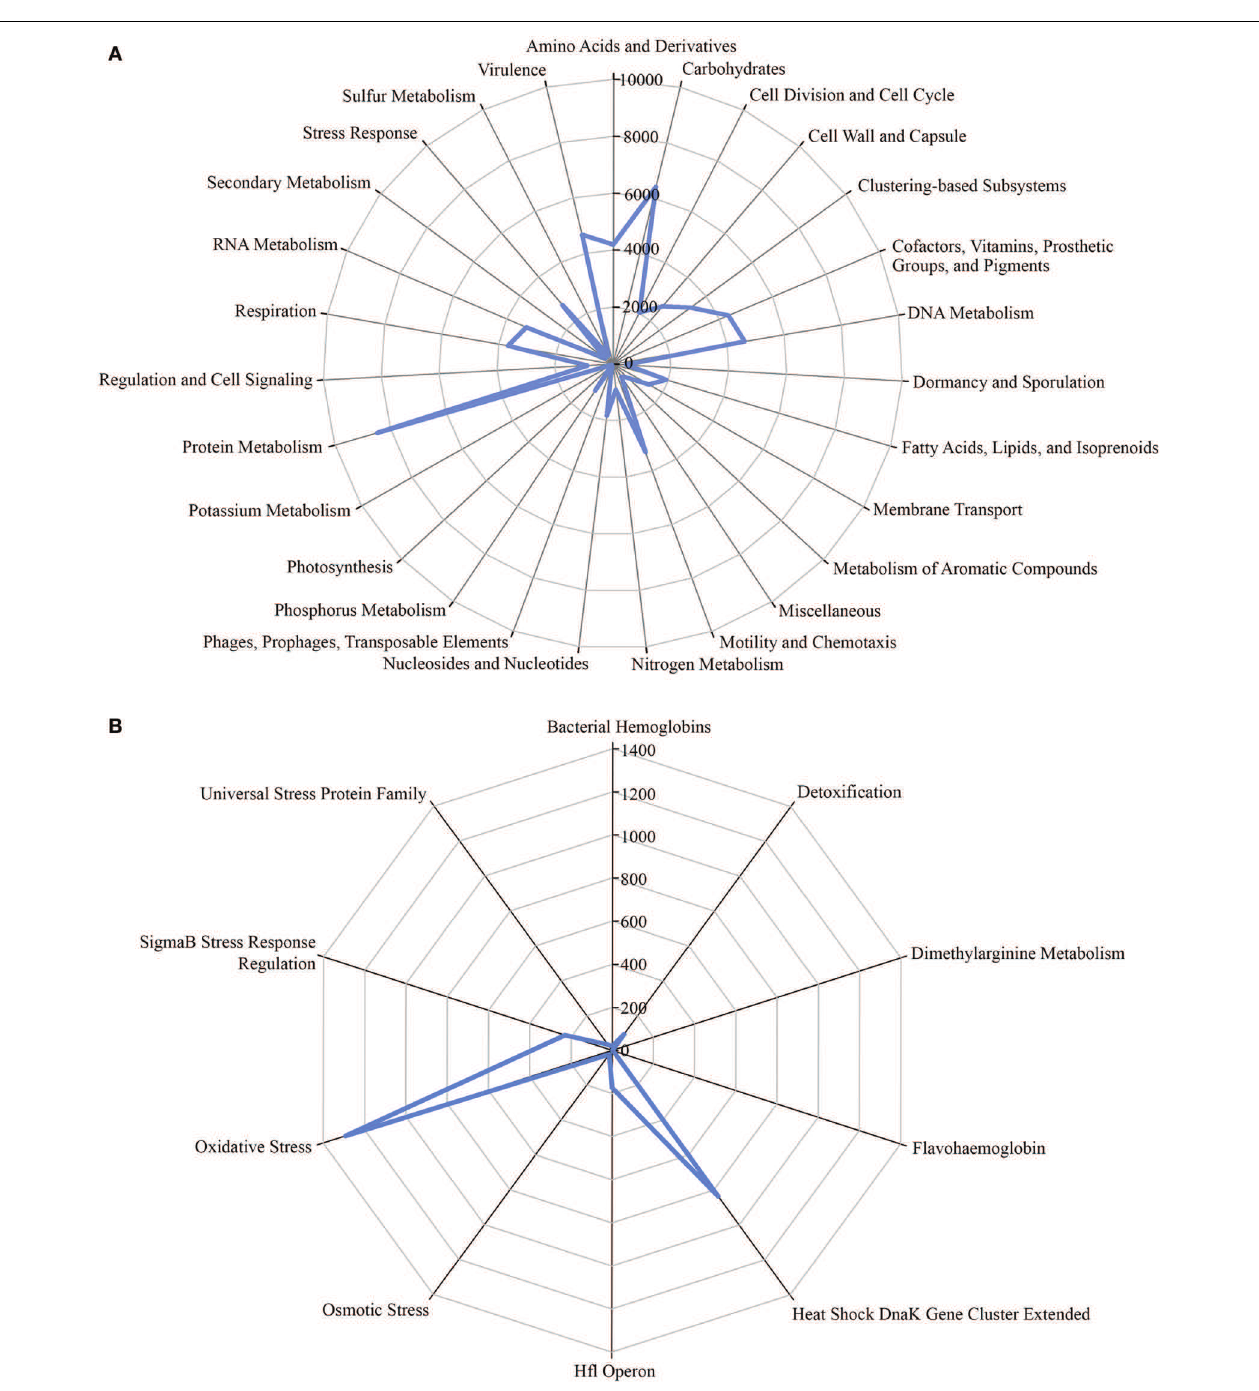
FIGURE 4 | The number of predicted ORFs that matched metabolic categories, based on SEED subsystem. (A) Major metabolic categories. (B) Stress responses.